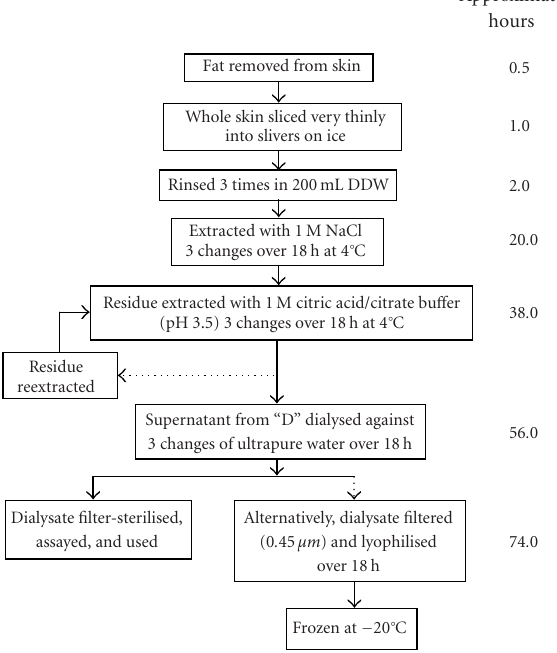
Schema 1. Preparation of human dermal extract